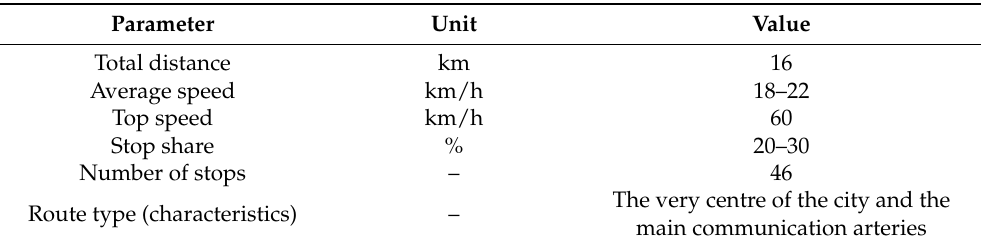
Table 5. Characteristics of the bus route no. 76 in the city of Pozna´n on which the emissions of hybrid bus were